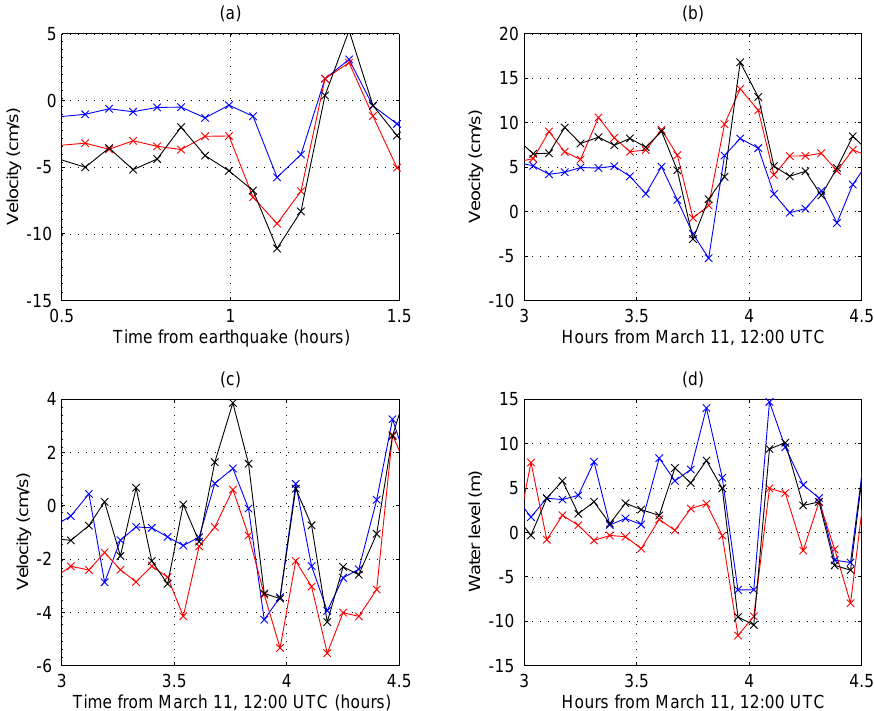
Figure 3. Time series of averaged velocity components showing the typical appearance around the tsunami arrival for three adjacent 2-km area bands. ( a ) A087 (Hokkaido, Japan, JST); ( b ) YHS2 (OR, USA, UTC); ( c ) BML1 (CA, USA, UTC); ( d ) PREY (CA, USA,